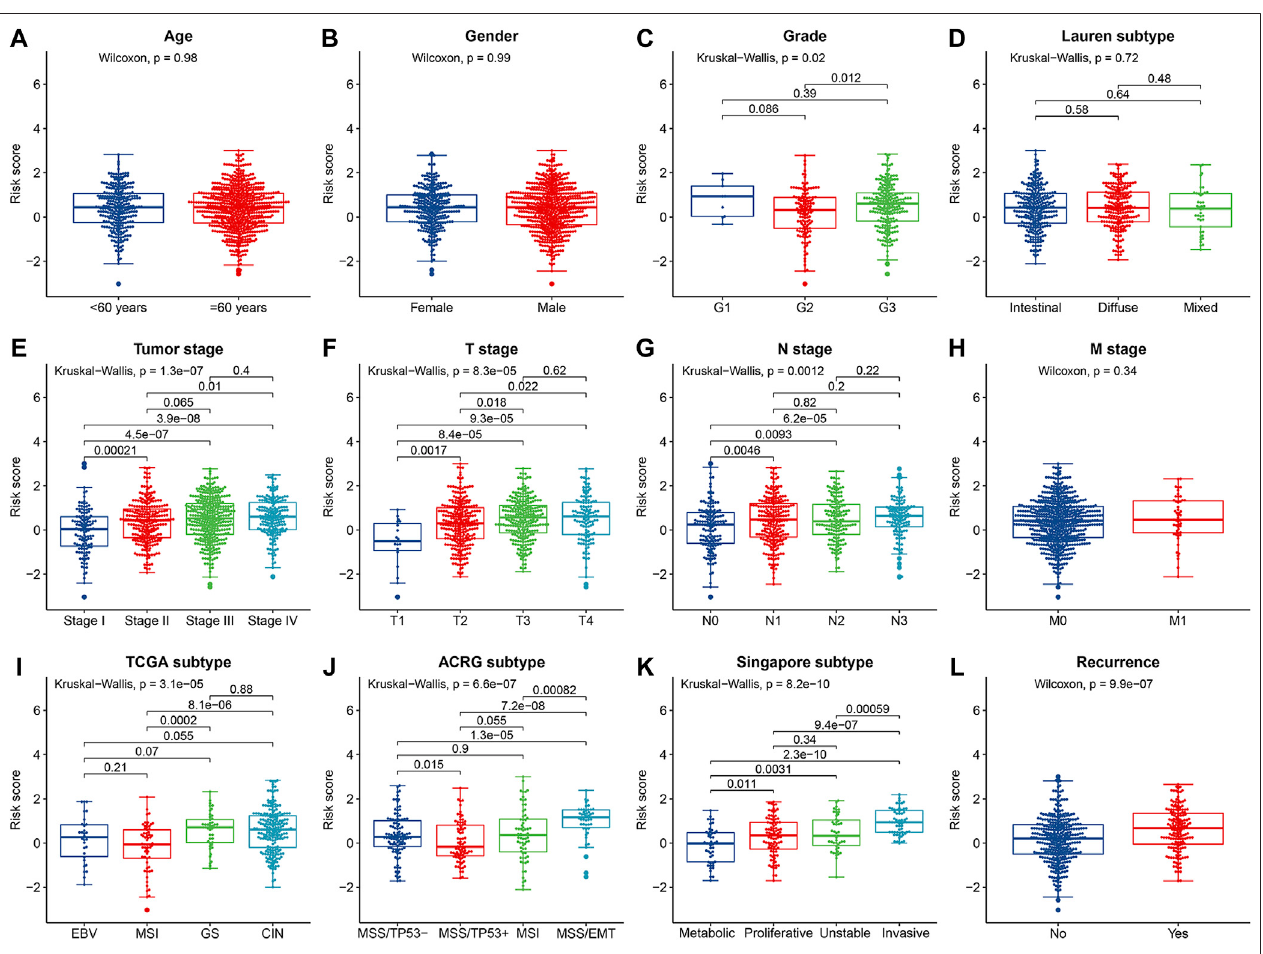
FIGURE 3 | The correlations between the prognostic risk score and (A) age; (B) gender; (C) tumor grade; (D) Lauren subtype; (E) tumor stage; (F) T stage; (G) N stage; (H) M stage; (I) TCGA subtype; (J) Asian Cancer Research Group (ACRG) subtype; (K) Singapore subtype; and (L) recurrence status.